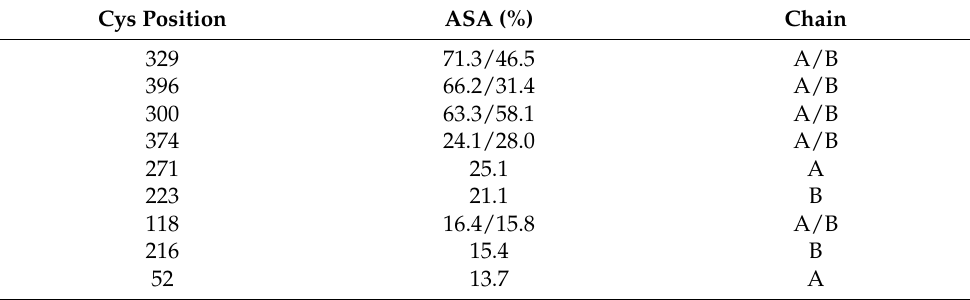
Table 1. Cys residues with more than 10% ASA.